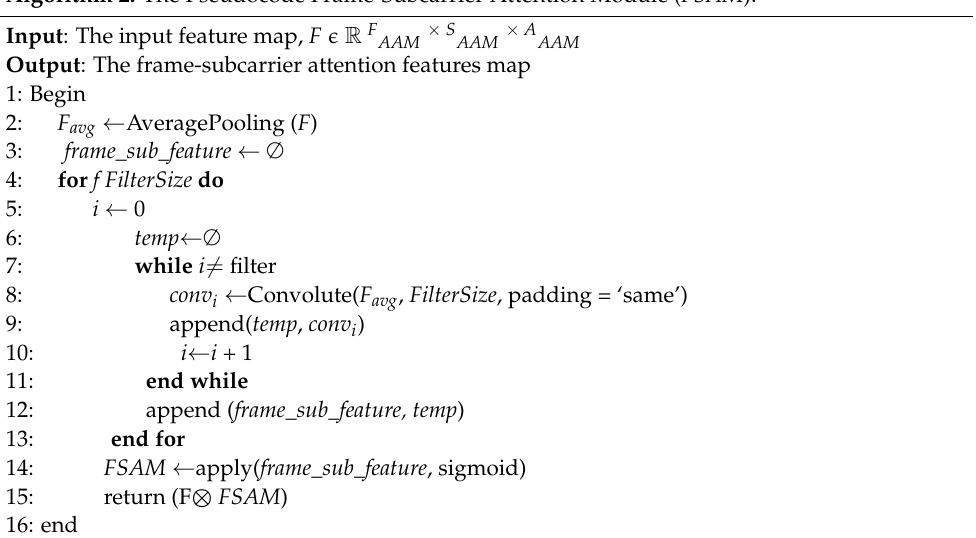
Algorithm 2: The Pseudocode Frame-Subcarrier Attention Module ( FSAM